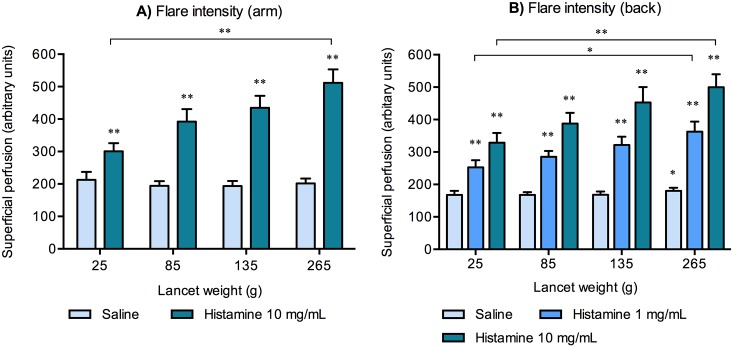
A) Changes in the mean superficial perfusion on the forearms according to the lancet weights: 25 g, 85 g, 135 g and 265 g. A difference in the mean superficial perfusion was seen from baseline to all the four applied lancet weights. B) On the back a difference in the mean superficial perfusion was seen from baseline to all the four applied lancet weights with both histamine concentrations (1 mg/mL and 10 mg/mL) and from baseline for the lancet weight of 265 g with saline as well. For each condition; n = 20. * = p < 0.05, ** = p < 0.01. Asterisks (*) or (**) placed just above the bars indicates significant difference from baseline superficial skin perfusion. Mean ± SEM.